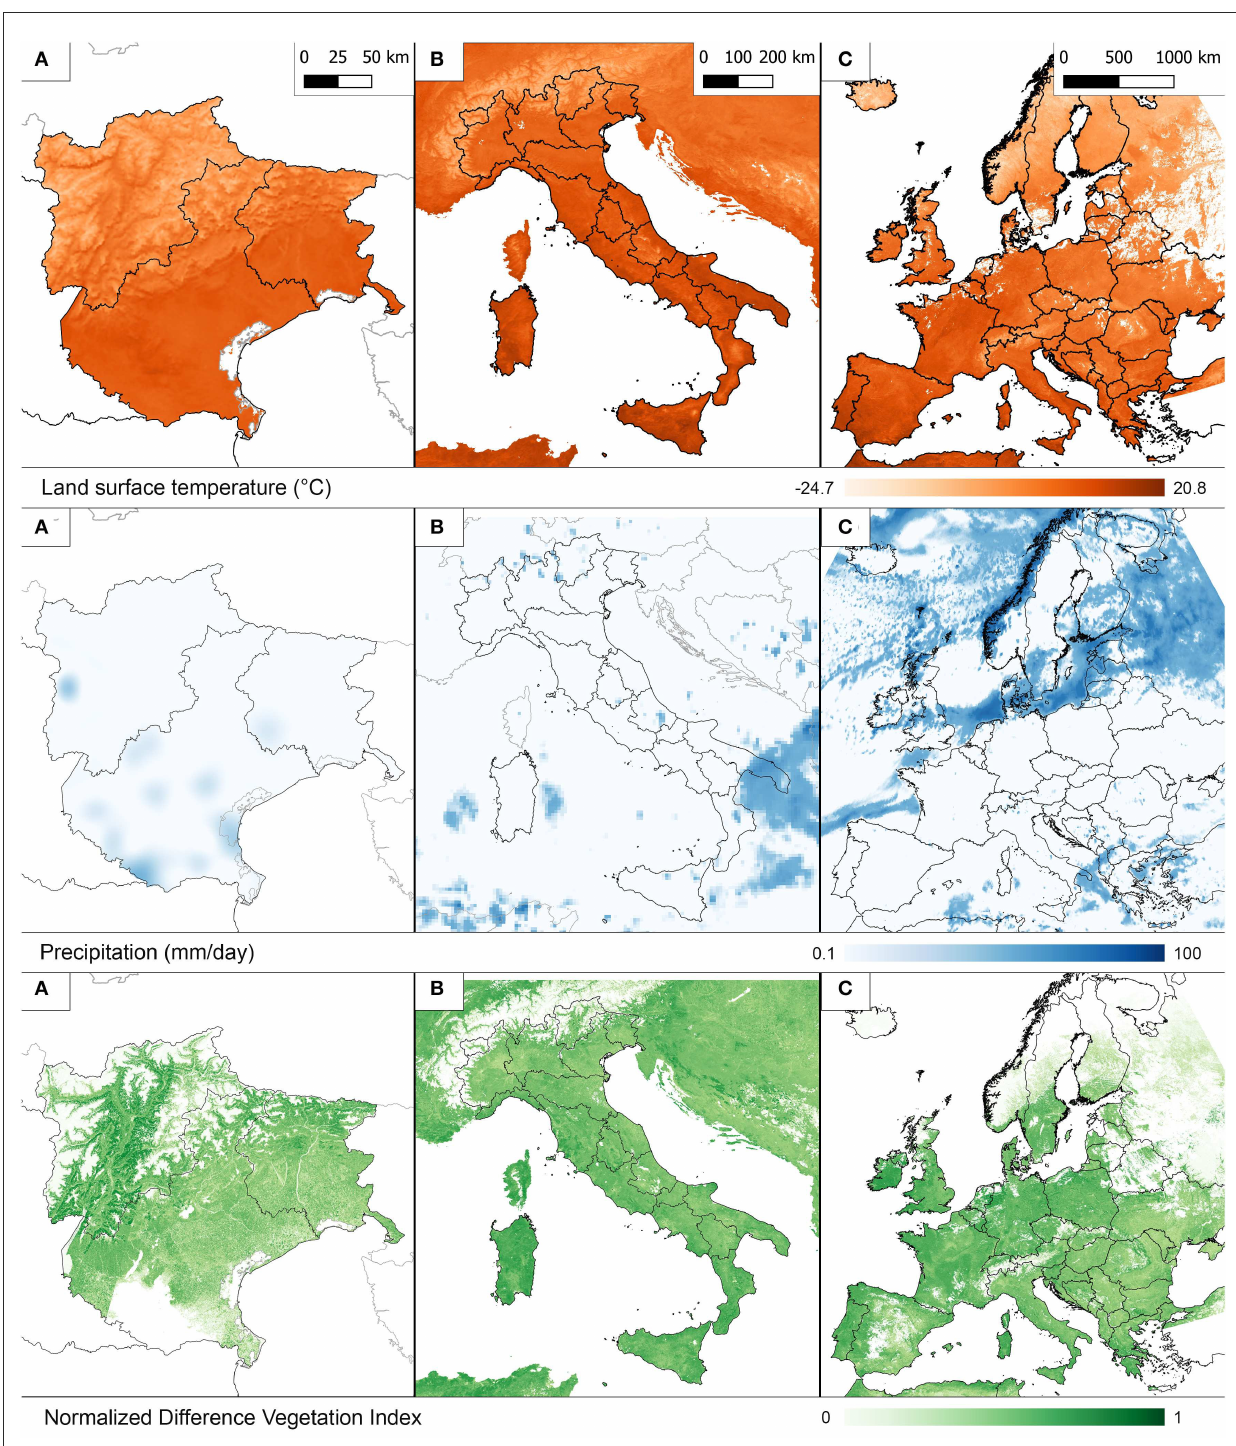
FIGURE5 Examples of Land Surface Temperature, Precipitation and NDVI at the three geographical levels: (A) Local, (B) Country, (C) Continental. Displayed data referred to MOD11A1 (day) on 12 January 2020 for local level, MOD11A2 (day) on 09 January 2020 for country and continental levels. To better represent Precipitation at all geographical levels a base-10 logarithmic scale was chosen. In the NDVI legend values were bound to 0–1 range (and not the complete − 1–1 scale) to facilitate visualizing the vegetation